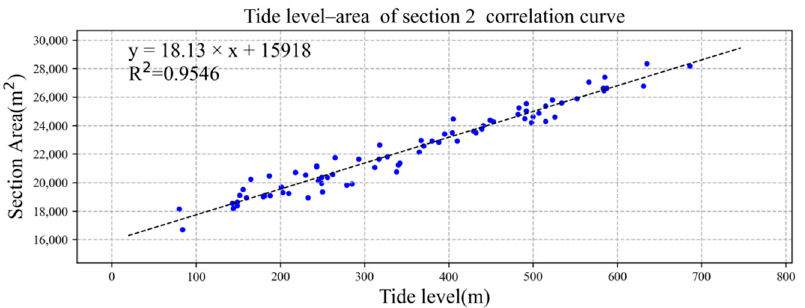
Figure 8. Linear correlation between tide level and section 2 area. The data of blue dots represent the relationship between tide level(x) and area of section 2(y).